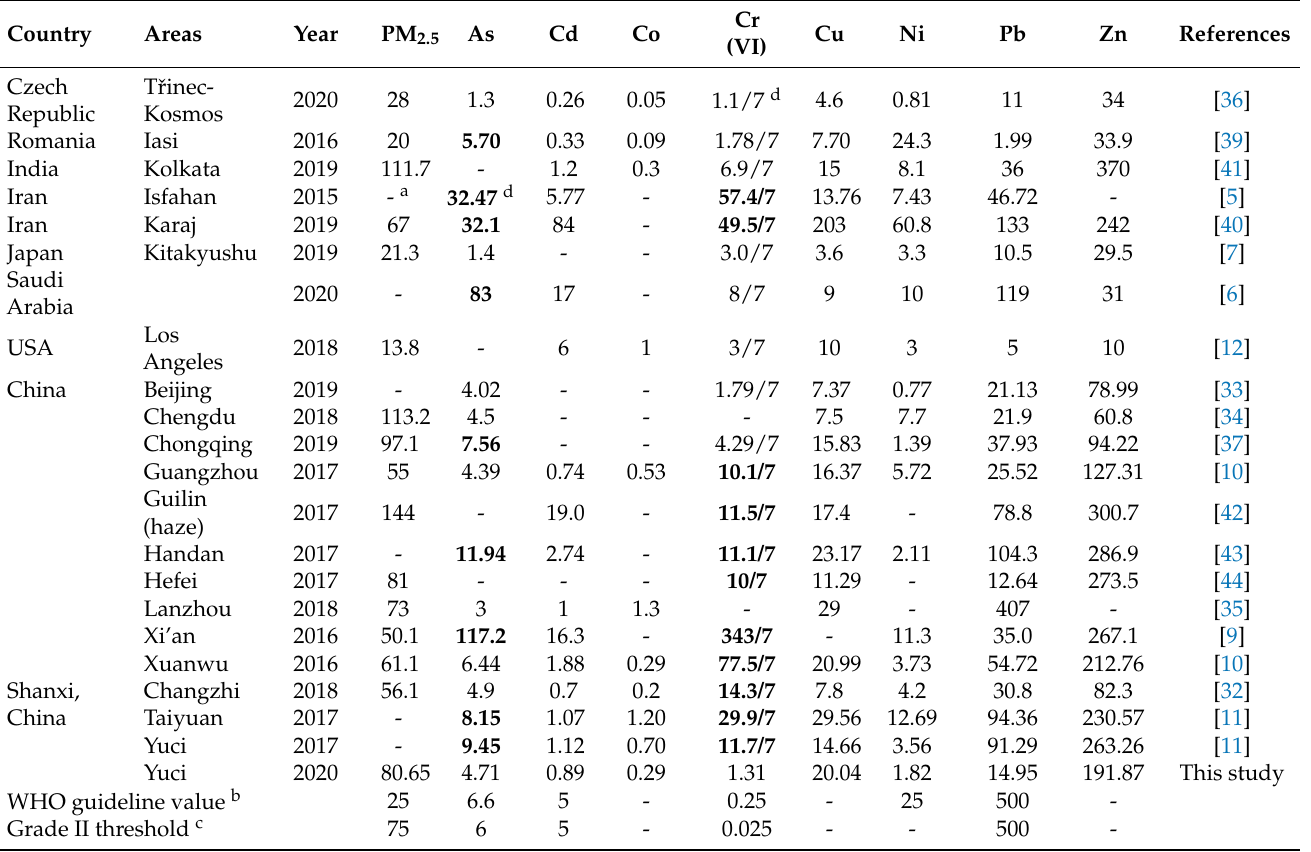
Table 3. A comparison of the results from other studies regarding the mean concentrations (ng · m − 3 ) of PM 2.5 -bound heavy metals in urban